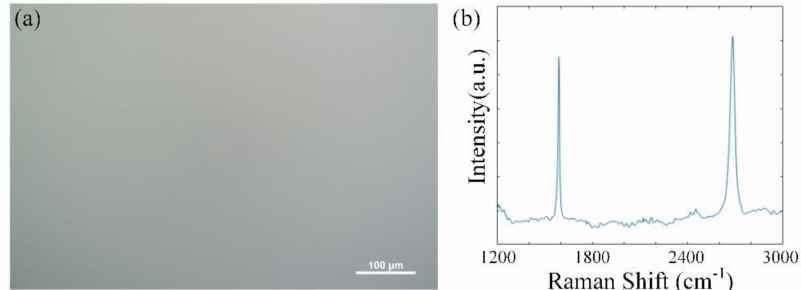
Figure 3. ( a ) The optical microscopy image of monolayer single-crystal graphene (SCG) on silica substrate. ( b ) Raman spectrum of the SCG-silica substrate.